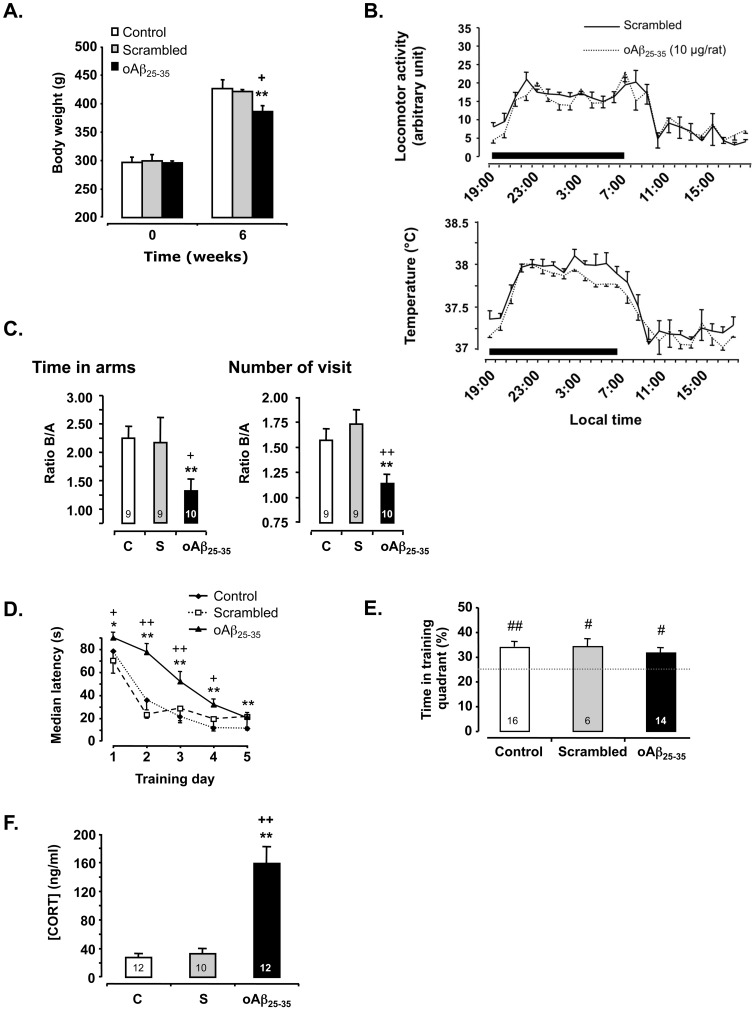
Physiological and behavioral effects of oAβ25–35.
A. Body weight variations determined 6 weeks after icv injection of scrambled Aβ25–35 peptide (10 µg/rat; scrambled group) or oAβ25–35 (10 µg/rat; Aβ25–35 group). The results are expressed as means ± SEM (with n = 6 per group). *p<0.05 vs. control value and +p<0.05 vs. scrambled value). B. Variations in locomotor activity and body temperature determined 6 weeks after icv injection of scrambled Aβ25–35 peptide (10 µg/rat; scrambled group; n  = 7) or oAβ25–35 (10 µg/rat; oAβ25–35 group; n = 7). Locomotor activity and body temperature were monitored using telemetric sensors. The thick black line indicates the nocturnal phase (7:00 PM to 7:00 AM). The results are means/hour obtained the 6th week following the icv injection. C. Effects of oAβ25–35 icv injection (10 µg/rat) on the ability of rats to perform a spatial short-term memory task (T-maze). Six weeks after icv injection, animals were allowed to explore the T-maze, with one short arm closed (B), for 10 min. After a 1 h time interval, the pattern of exploration of the whole maze was recorded for 2 min. The icv injection of the scrambled Aβ25–35 peptide (10 µg/rat) served as negative control. The results are expressed as means ± SEM. **p<0.01 vs. control un-injected rats, +p<0.05 and ++p<0.01 vs. scrambled treated rats. The number of animals in each group is indicated within the columns. D. Effects of oAβ25–35 icv injection (10 µg/rat) on rat behavior in a spatial long-term memory test (Water-maze). Six weeks after icv injection, animals were allowed to swim for 90 s to find the training platform and 60 s without the platform for retention. The icv injection of the scrambled Aβ25–35 peptide (10 µg/rat) served as negative control. The results are expressed as means ± SEM. *p<0.05 and **p<0.01 vs. control un-injected rats, +p<0.05 and ++p<0.01 vs. scrambled treated rats. E. The probe test was performed 4 h after the last training trial in a single 60 s-duration swimming without platform. The presence in the training quadrant was analyzed over the chance level (25%): # p<0.05 and ## p<0.01. The number of animals in each group is indicated within the columns. F. Variations in plasmatic corticosterone (CORT) levels determined in rats 6 weeks after icv injection of Aβ25–35 scrambled peptide (10 µg/rat; negative control) or oAβ25–35 (10 µg/rat). The values are means ± SEM. **p<0.01 vs. control un-injected rats (control group: C) and ++p<0.01 vs. scrambled treated rats. The number of animals in each group is indicated within the columns.